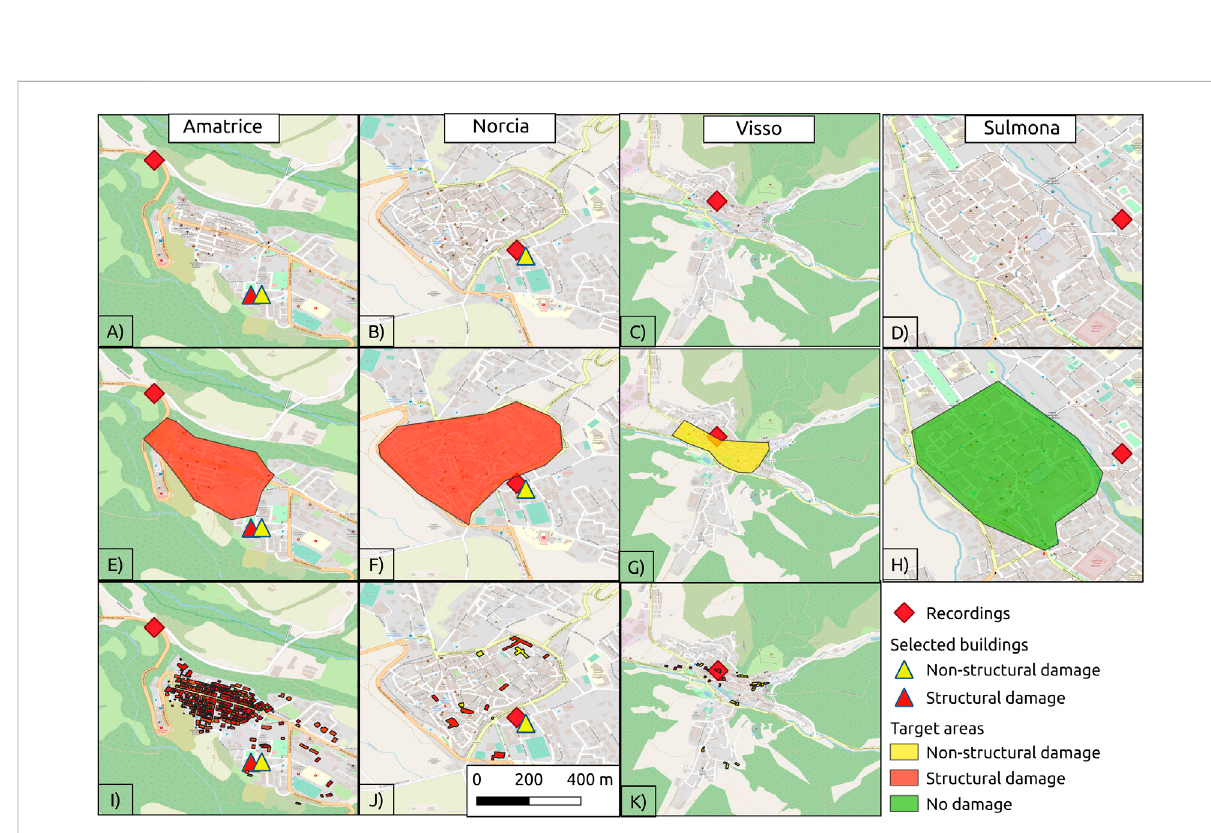
FIGURE 2 (A – D) :Location of the earthquake recordings and the selected buildings for the four target areas (from left to right, Amatrice, Norcia, Visso and Sulmona). (E – H) : Results of DARR for 3-story simple stone URM buildings in the target areas of Amatrice, Norcia, Visso and Sulmona. (I – K) : Documented damage collected from post-event surveys after the 24 August 2016 event in Amatrice, Norcia and Visso. The damage patterns are extracted from OpenStreetMap (OpenStreetMap contributors, 2015) and are in good agreement with the documented post-event damage (e.g., Gaudiosi et al., 2016; Stewart and Lanzo, 2018; D ’ Ayala et al.,. 2019). In Sulmona no damage was observed in